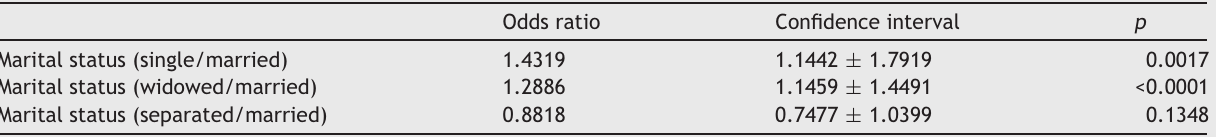
Result of the simple logistic regression of marital status for the chance of having hearing loss complaints in comparison to the married marital